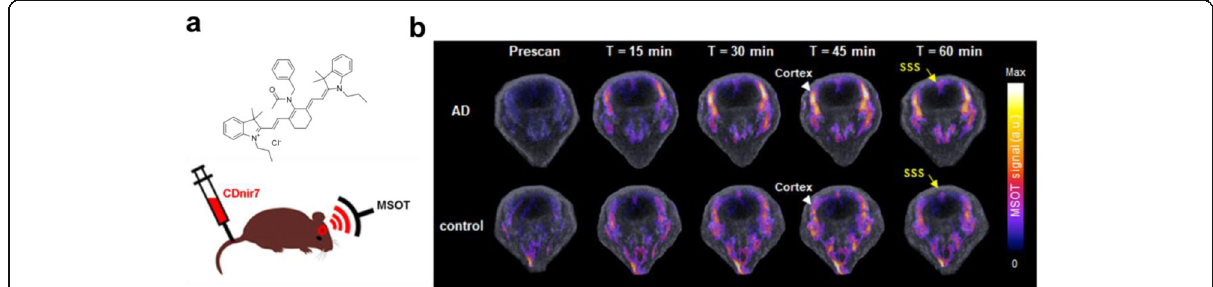
Fig. 4 Modality of MSOT imaging. a The chemical structure of CDnir7 and the experimental scheme. b MSOT signals in the cortex of both AD and control brains before (Prescan) and after the intravenous injection of CDnir7. SSS, superior sagittal sinus. Adapted with permission Park et al. 2019a ,